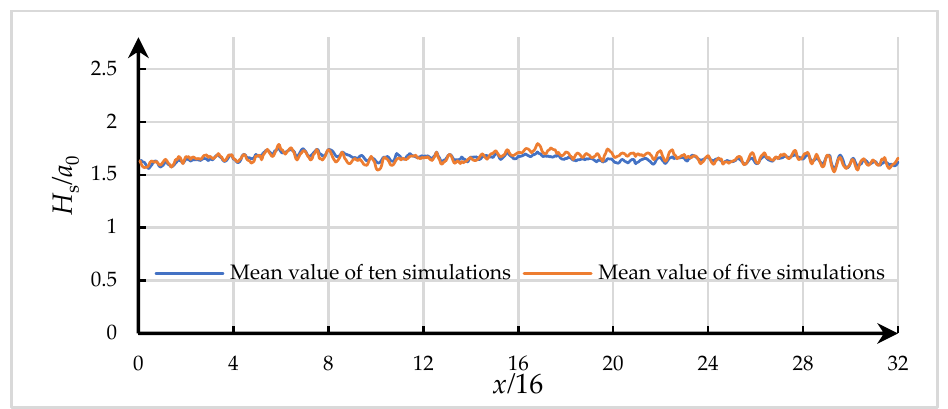
Figure 7. Distributions of average significant wave heights H s along the x -axis under five and ten simulations for M = 3.